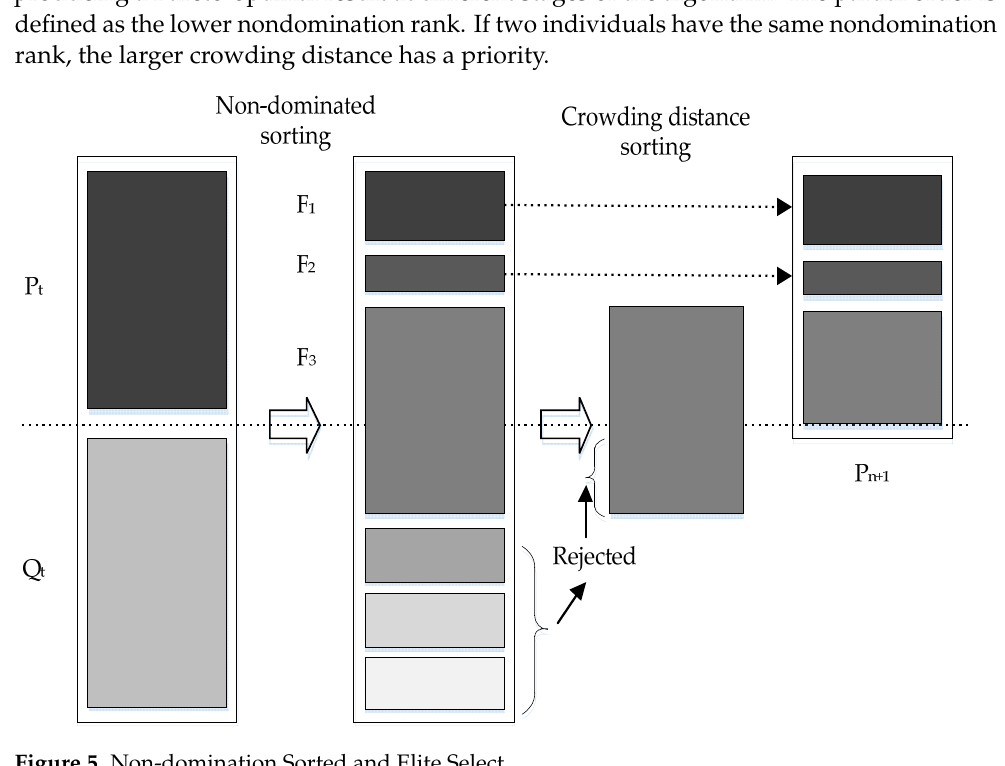
Figure 5. Non-domination Sorted and Elite Select.